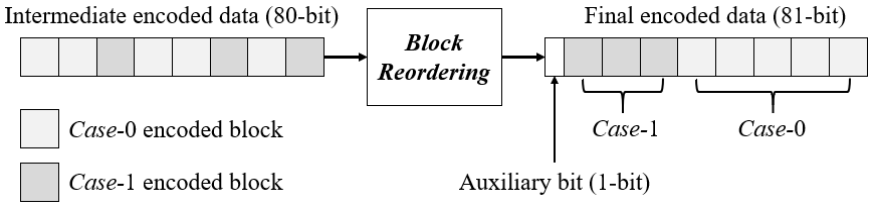
Figure 6. Function of Block Reordering logic.